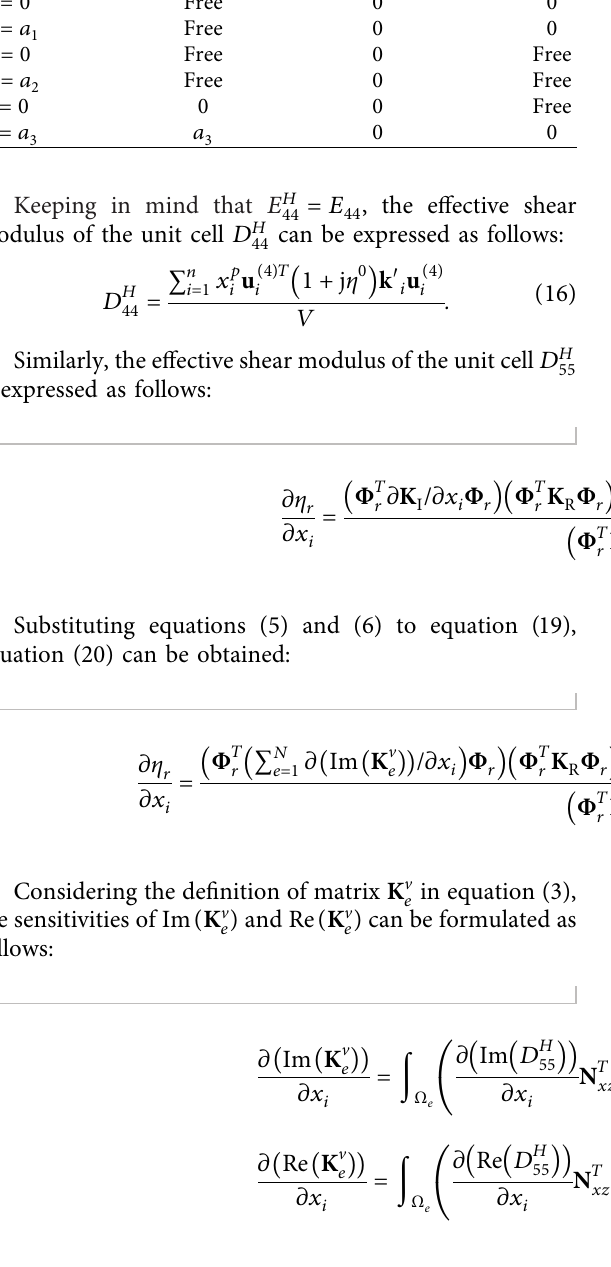
Table 2: Boundary conditions for the FE model of the unit cell. Nodes u